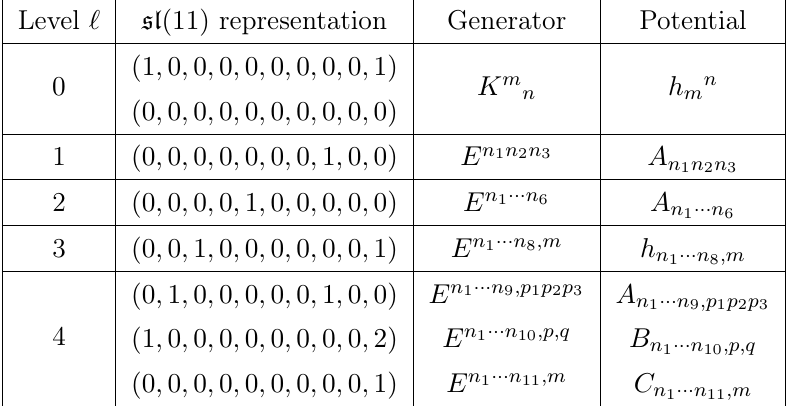
Table 4 . Level decomposition of e 11 under its gl (11) subalgebra obtained by deleting node 11 from the Dynkin diagram in figure 1, up to level ‘ = 4